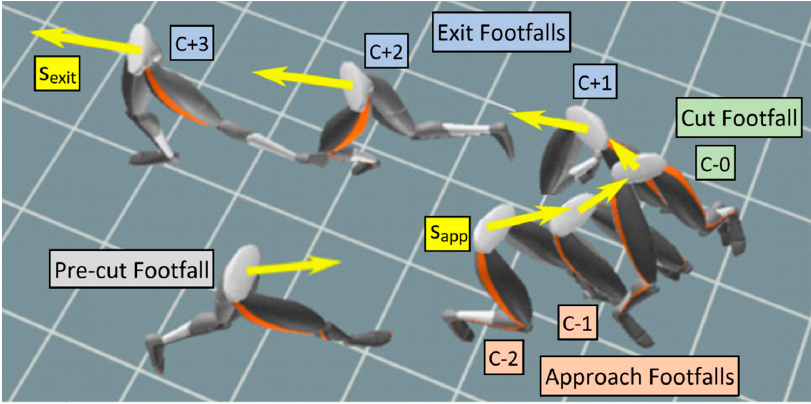
Figure 2. The 3 phases of cuts are the approach footfalls, the cut footfall, and the exit footfalls. The start of each footfall is shown. The yellow arrows represent the (cid:1819) (cid:1806)(cid:1806) of each cut step (not drawn to